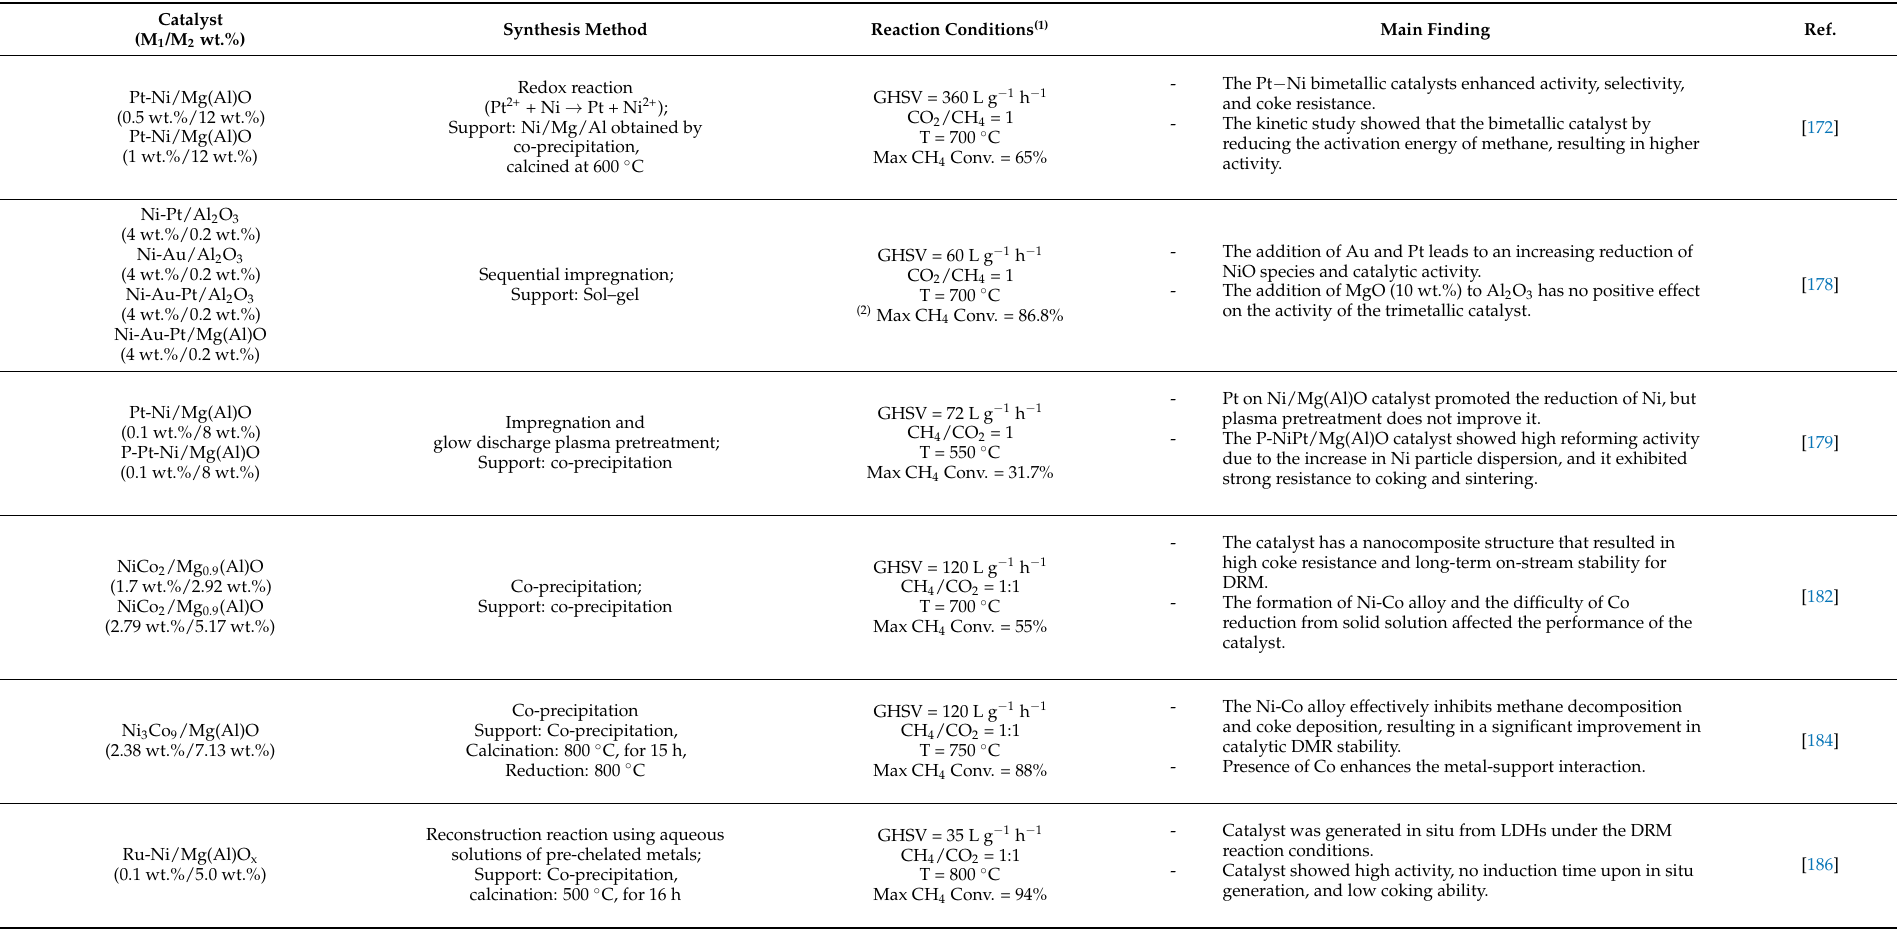
Table 6. Bimetallic Ni catalysts supported on Mg(Al)O for